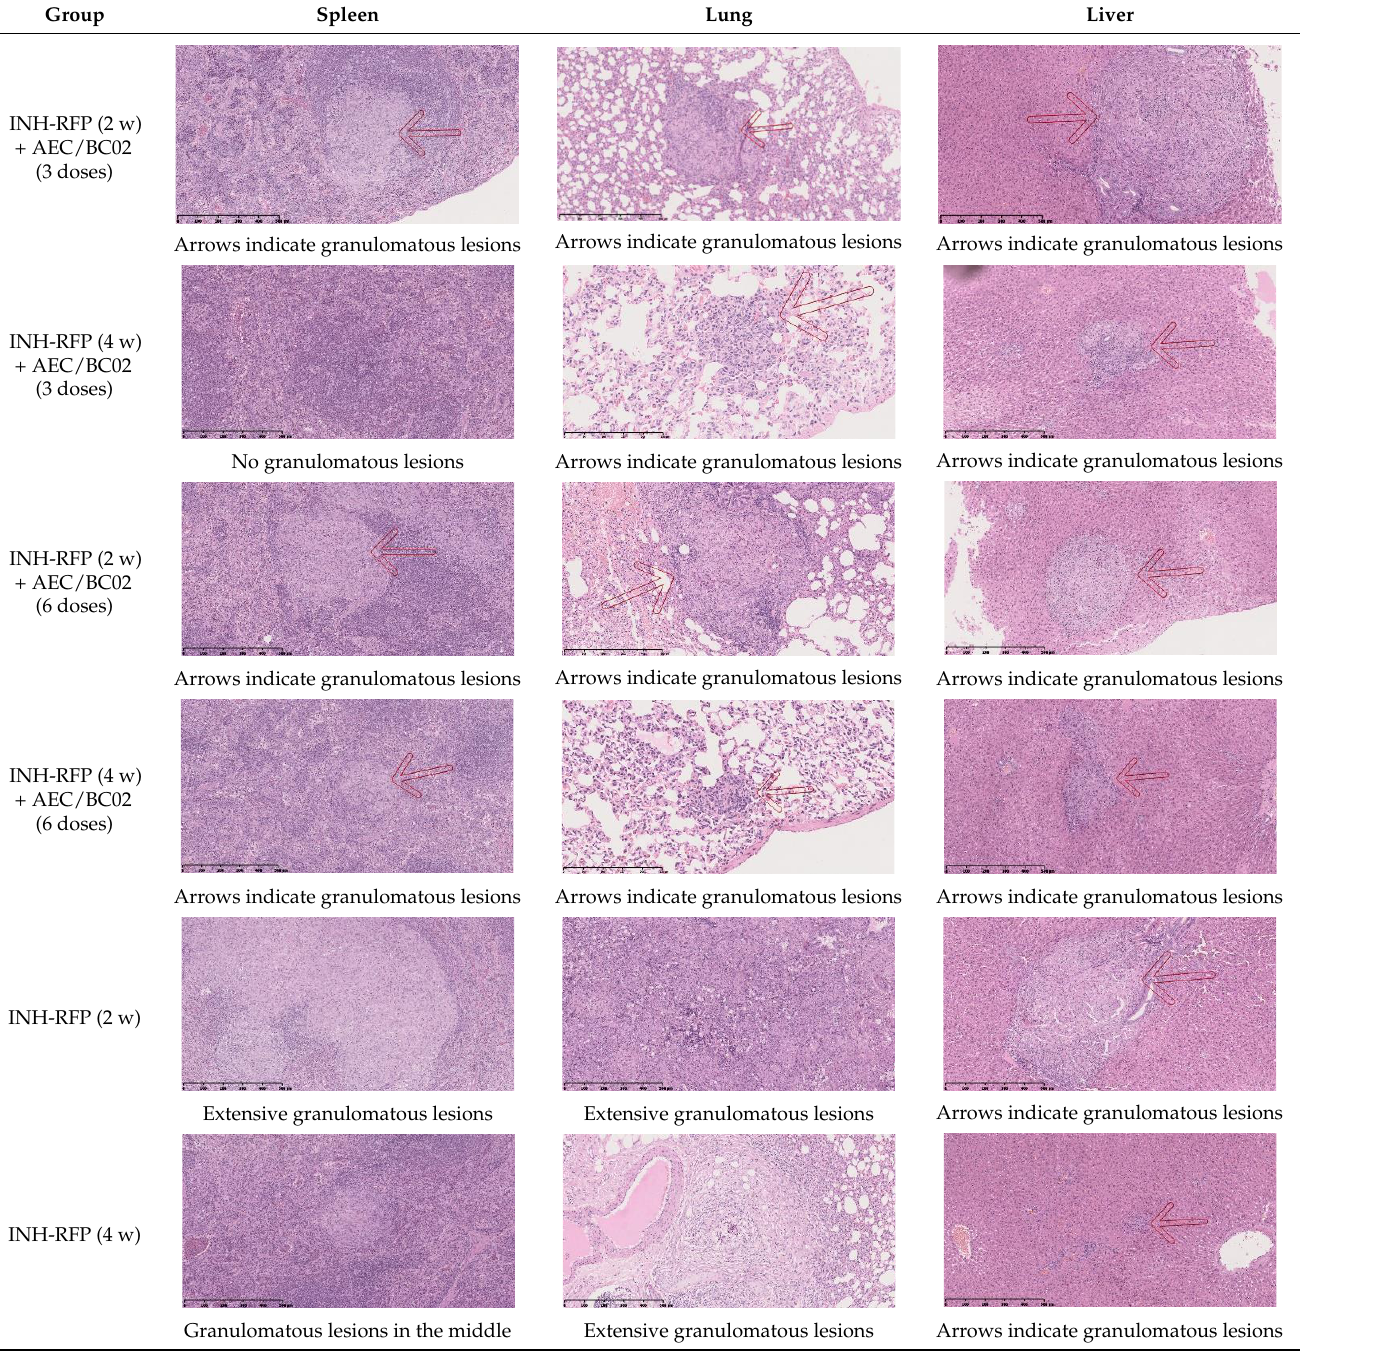
Arrows indicate granulomatous le- sions